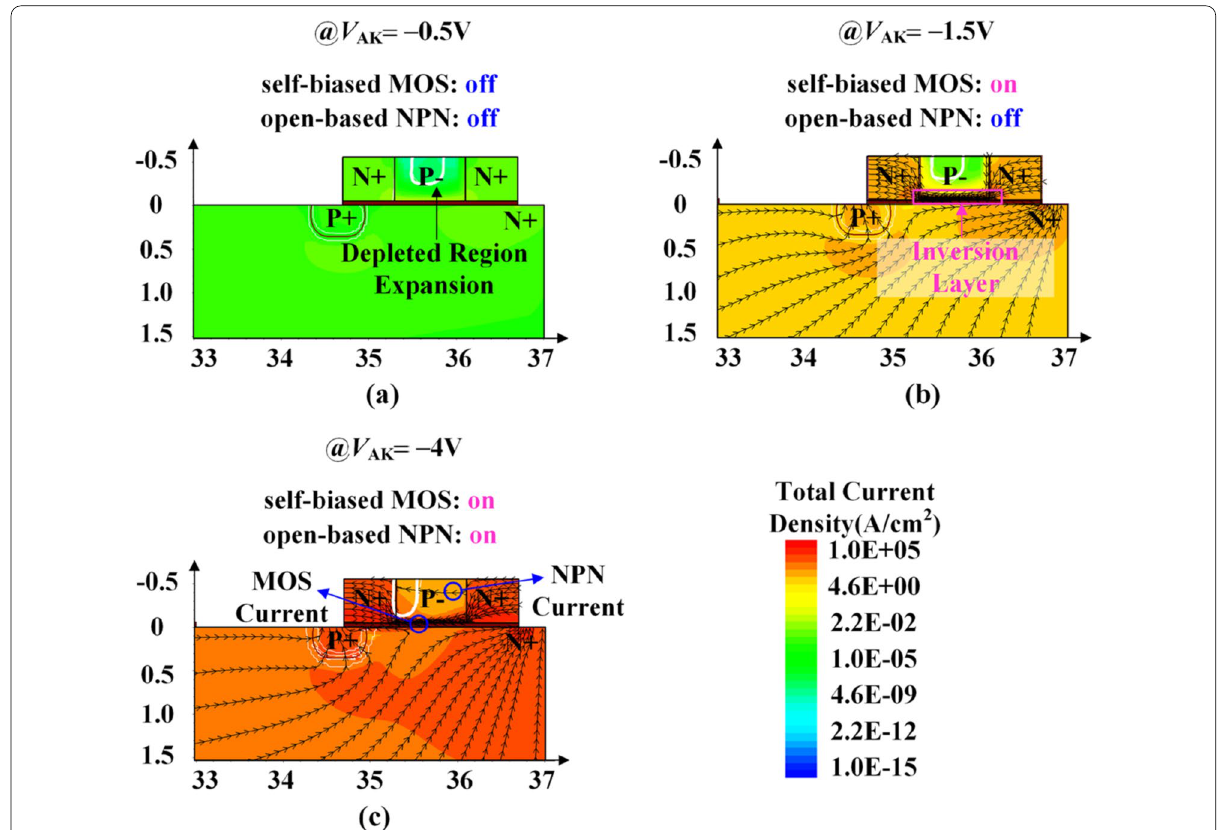
Fig. 4 Current flowlines in the reverse-conducting state for the ISM RC-LIGBT ( N P V AK 1.5 V; c V AK = −